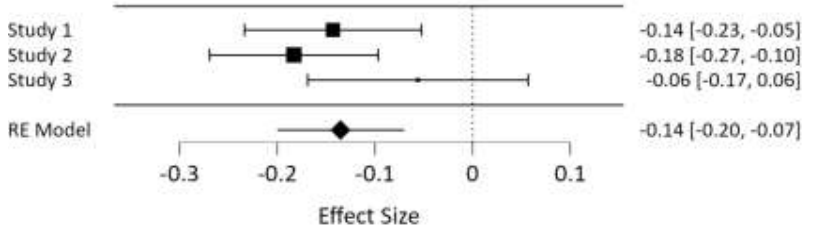
Figure 10. Forest plot of meta-analysis of Motivation for knowledge and Emotional stability